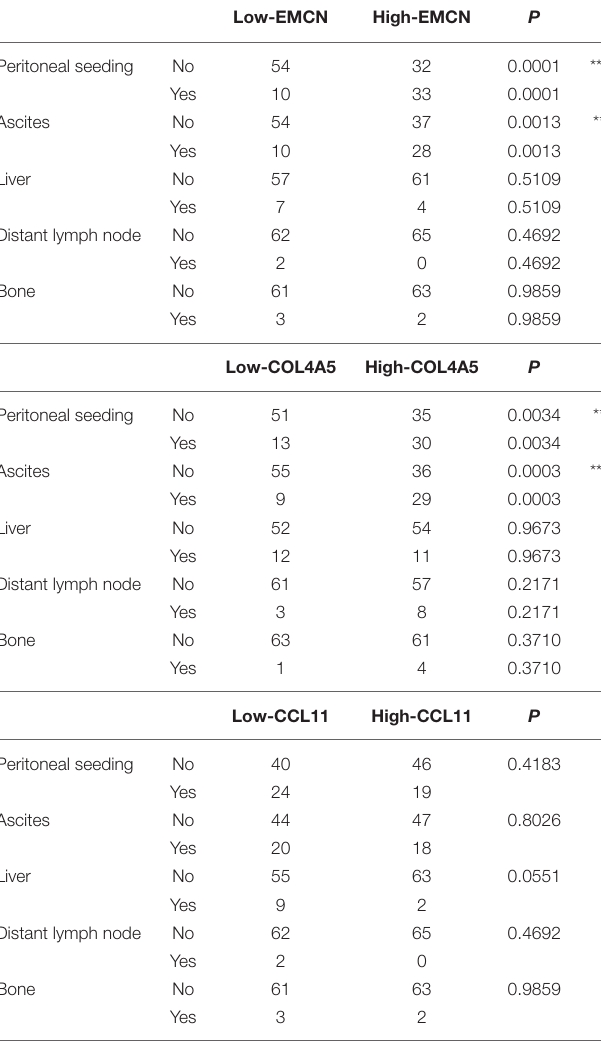
TABLE 4 | The correlation of EMCN, COL4A5, and CCL11 with the clinical pathological parameters related to metastasis in diffuse type GC.